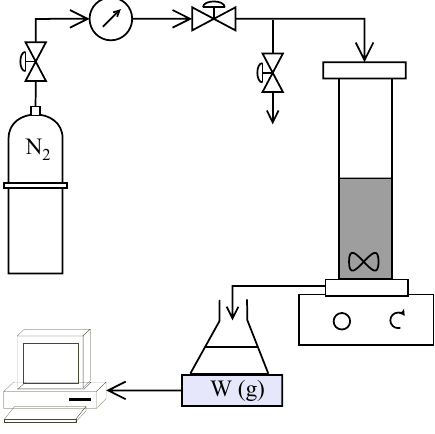
Figure 2. Schematic of experimental setup used in the study.